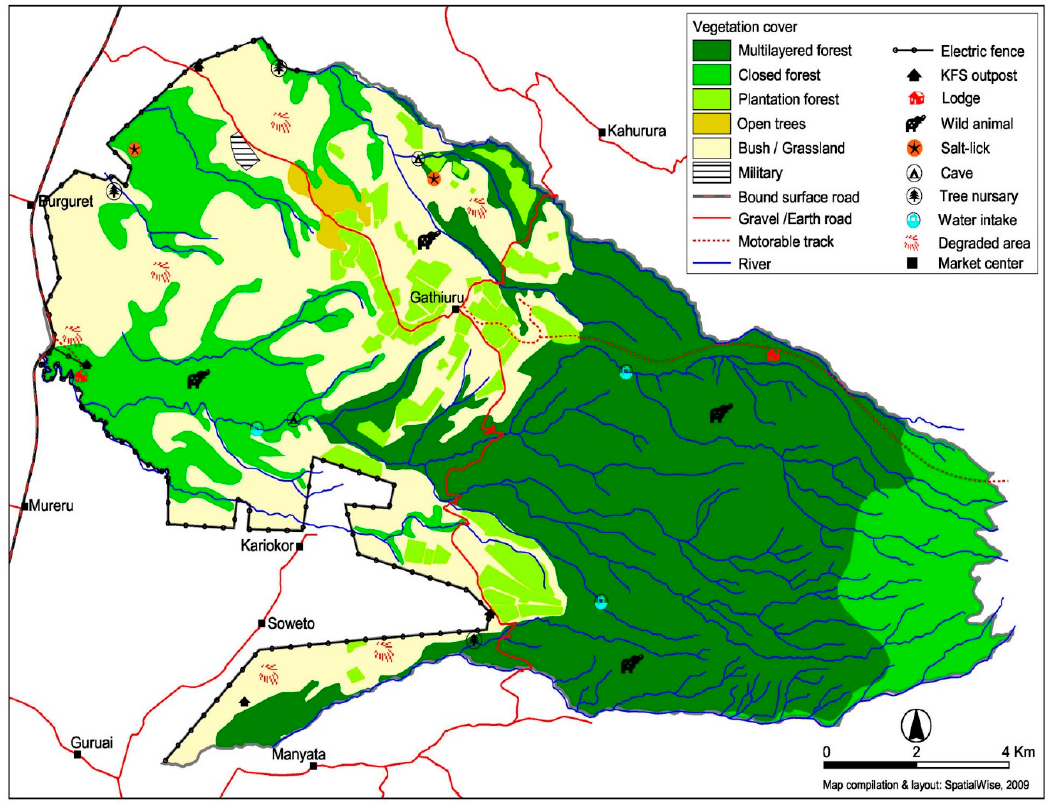
Figure 2. Gathiuru Forest Vegetation Types and Management Units, 2009.